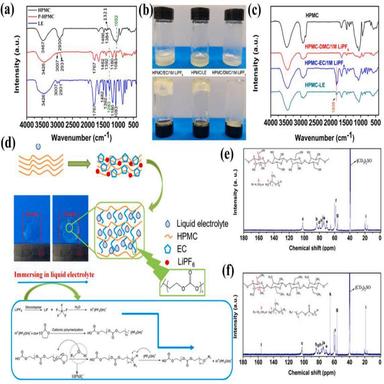
(a) FTIR spectra of HPMC, LE and P-HPMC. (b) The digital photograph of HPMC was dissolved in different solvent (EC/1 M LiPF6, LE, DMC/1 M LiPF6). (c) FTIR spectra of HPMC, HPMC-DMC/1 M LiPF6, HPMC-EC/1 M LiPF6, HPMC-LE. (d) Schematic diagram of the high liquid electrolyte uptake caused by the chemical reaction between HPMC and EC induced by LiPF6. 13C NMR spectrum of (e) HPMC and (f) P-HPMC.